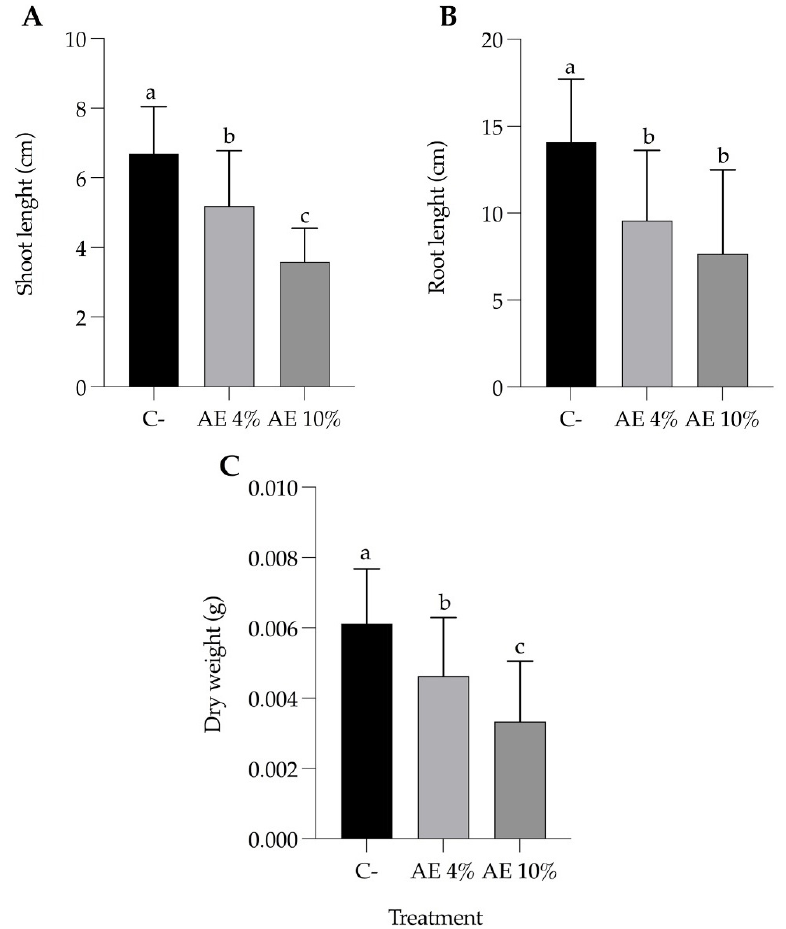
Figure 8. Substrate leaching bioassay with barnyardgrass. Parameters after 8 days of leaching (and 4 water applications): ( A ) shoot length, ( B ) root length, and ( C ) seedling dry weight. Abbreviations: distilled water (C-), aqueous extract at 4% (AE 4%), and aqueous extract at 10% (AE 10%). Bars represent the mean + SD. Different letters indicate significant differences by one-way ANOVA and Tukey test ( p ≤ 0.05).